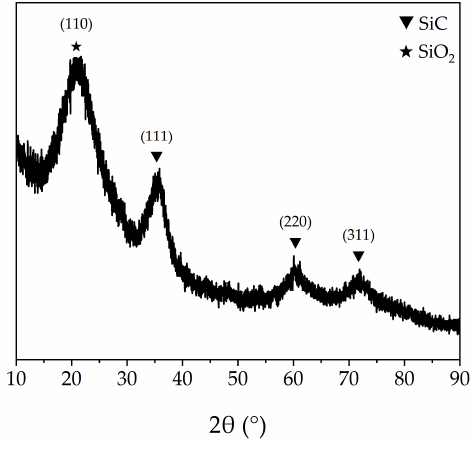
Figure 5. XRD paern of Si−C−O−Ti−B fibers. Figure 5. XRD pattern of Si–C–O–Ti–B